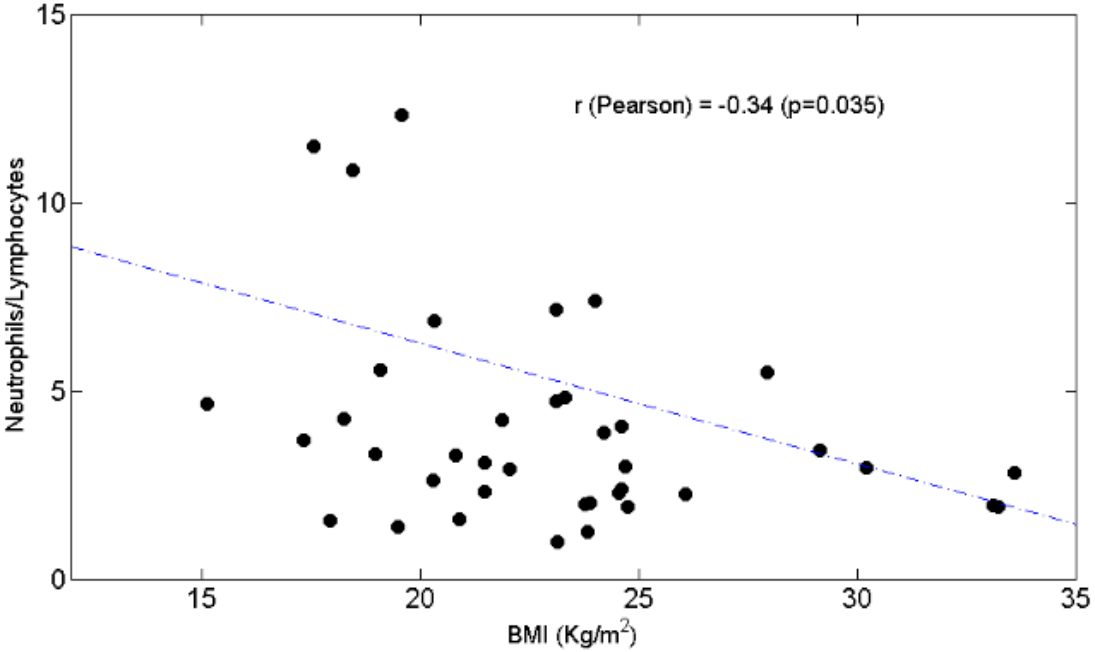
Figure 7. Scatter plot of the neutrophils/lymphocytes ratio (y axis) as a function of BMI (Body Mass Index) (x axis). The value of Pearson’s correlation coefficient and corresponding p value are also reported.